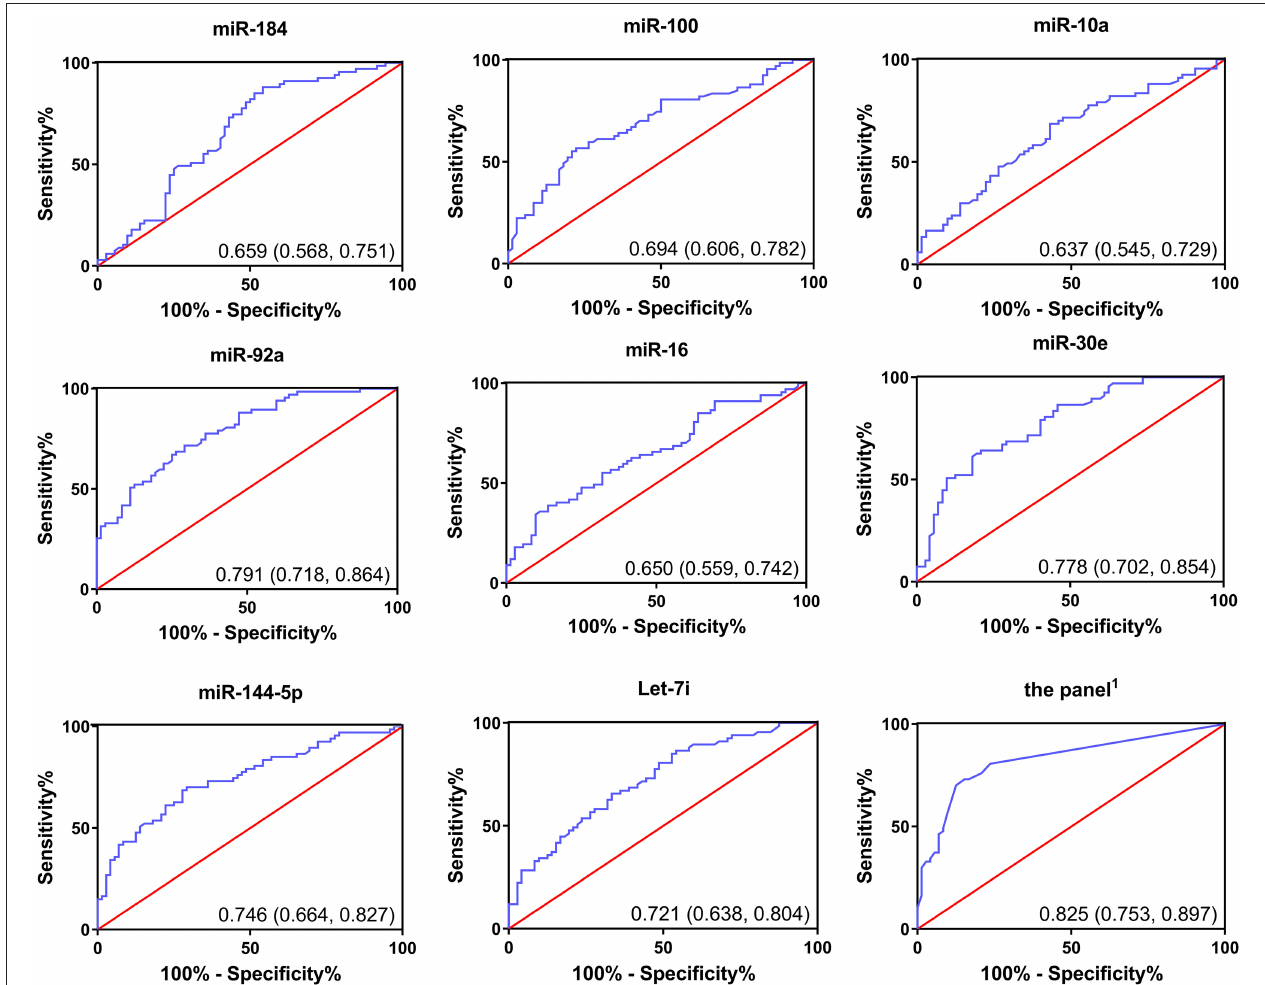
FIGURE 5 | Receiver operating curves (ROC) of selected miRNAs for differentiation between responsive patients and resistant patients based on the plasma exosomal miRNA